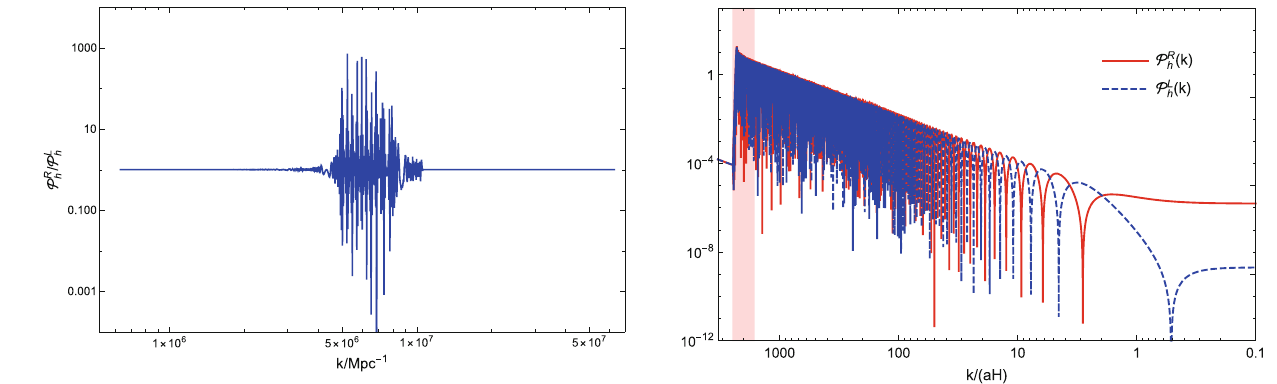
( k ) and P L ( k ) for a resonant k mode as a h h